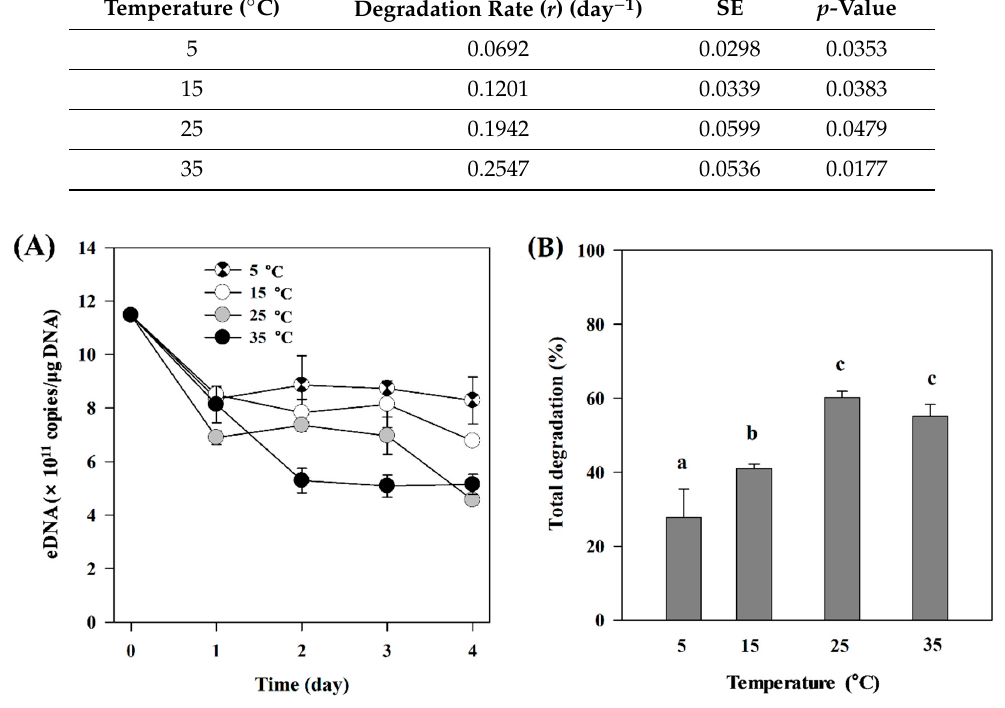
Table 2. Degradation rates of exDNA under different temperature treatments (5 °C, 15 °C, 25 °C, and 35 °C) during incubation for 4 days. Degradation rates were estimated by fitting the number of copies of each set of DNA to an exponential decay curve. SE: standard error.